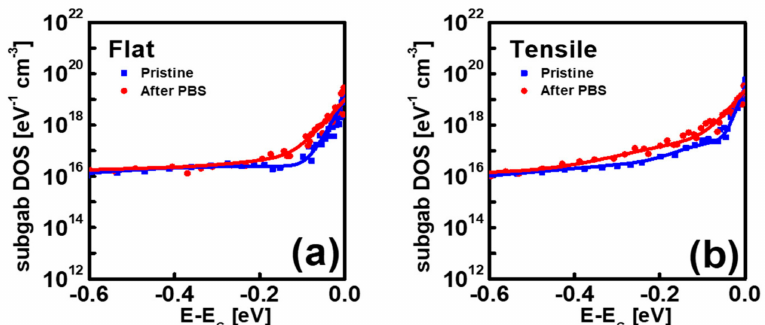
Figure 6. Energy distribution of the subgap DOS obtained from the IGZO TFTs before and after PBS application (stress time: 2000 s) ( a ) at the flat state and ( b ) under tensile bending